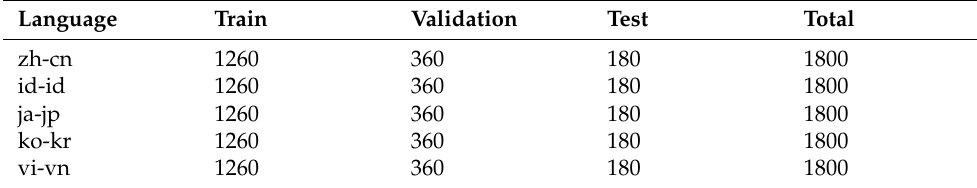
Table 2. Oriental language dataset